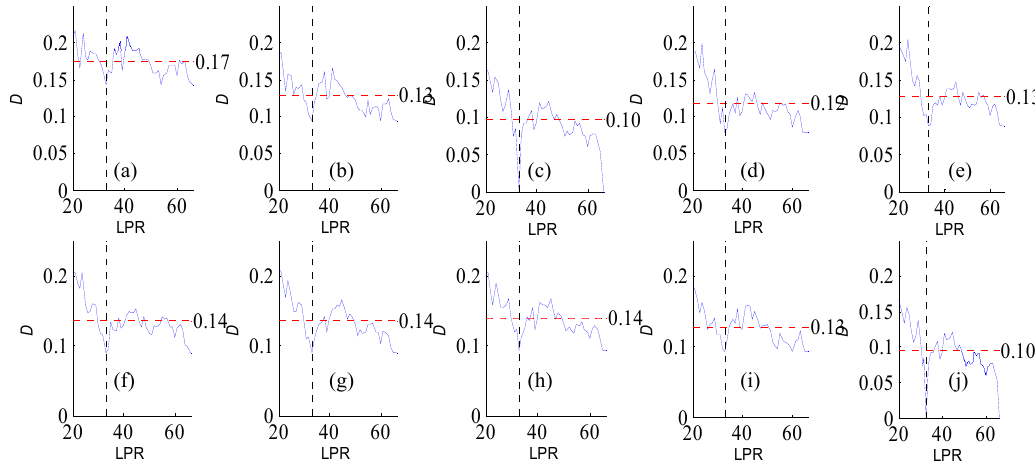
Figure A17. Variation of flow regime alteration degree (D) measured by the RVA with change in the length of pre-impact flow time series (LPR) under a periodicity of 33 years. ( a – j ) correspond to pre-impact flow time series length = 24, 28, 33, 38, 42, 47, 52, 57, 61, and 66 years, respectively. The abscissa value for the vertical dotted line is 33. The ordinate value for the horizontal dotted line is the mean degree of flow regime alteration in each subfigure.